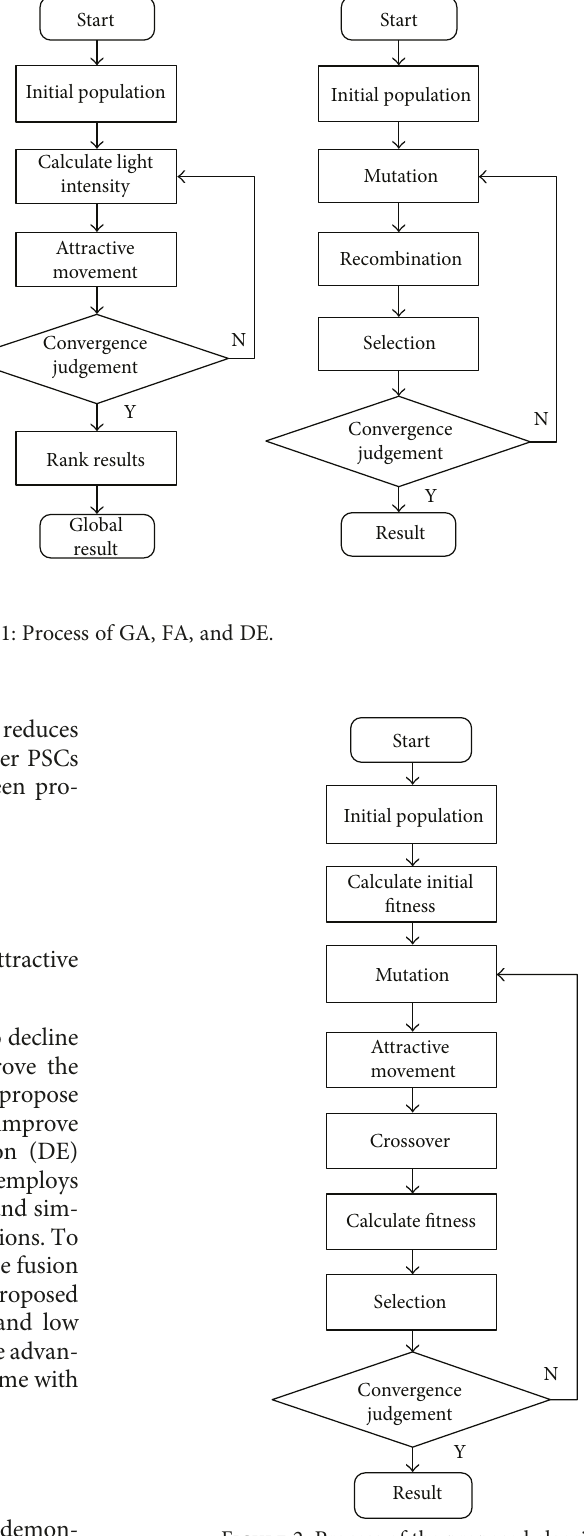
Figure 2: Process of the proposed